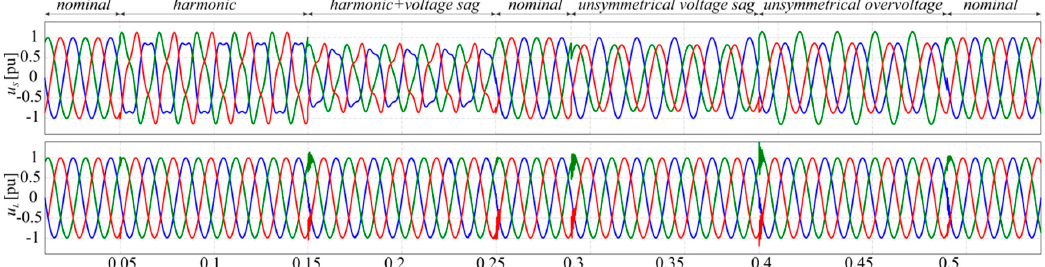
Figure 18. MPC of an HT voltage compensator with an MC and minimalization of the output voltage tracking error and input power factor.